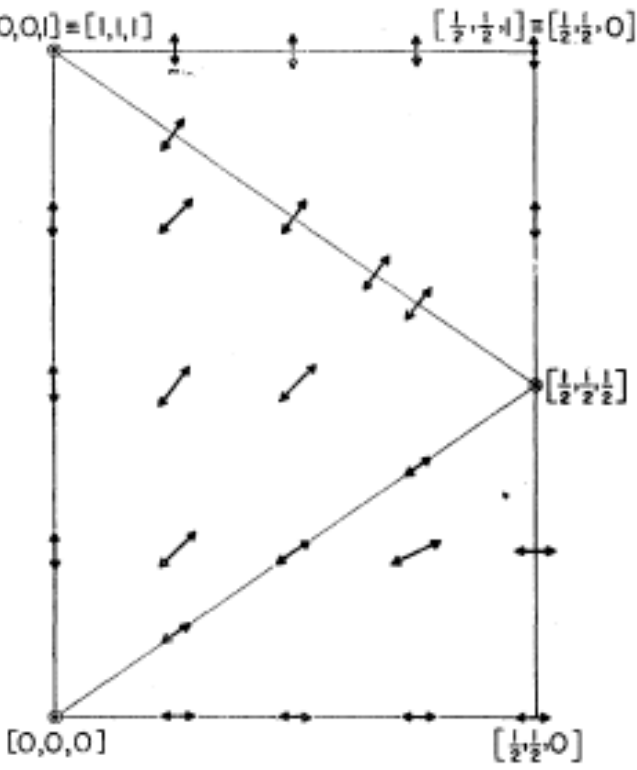
Figure 23. The approximate polarization directions for the high-frequency mode in the (110) plane for sodium. These were deduced from symmetry considerations, intensity measurements, dispersion curve continuity, and the values of the force constants for the fifth neighbor model. This figure is taken from Figure 3 of ref. [64] courtesy of the IAEA.